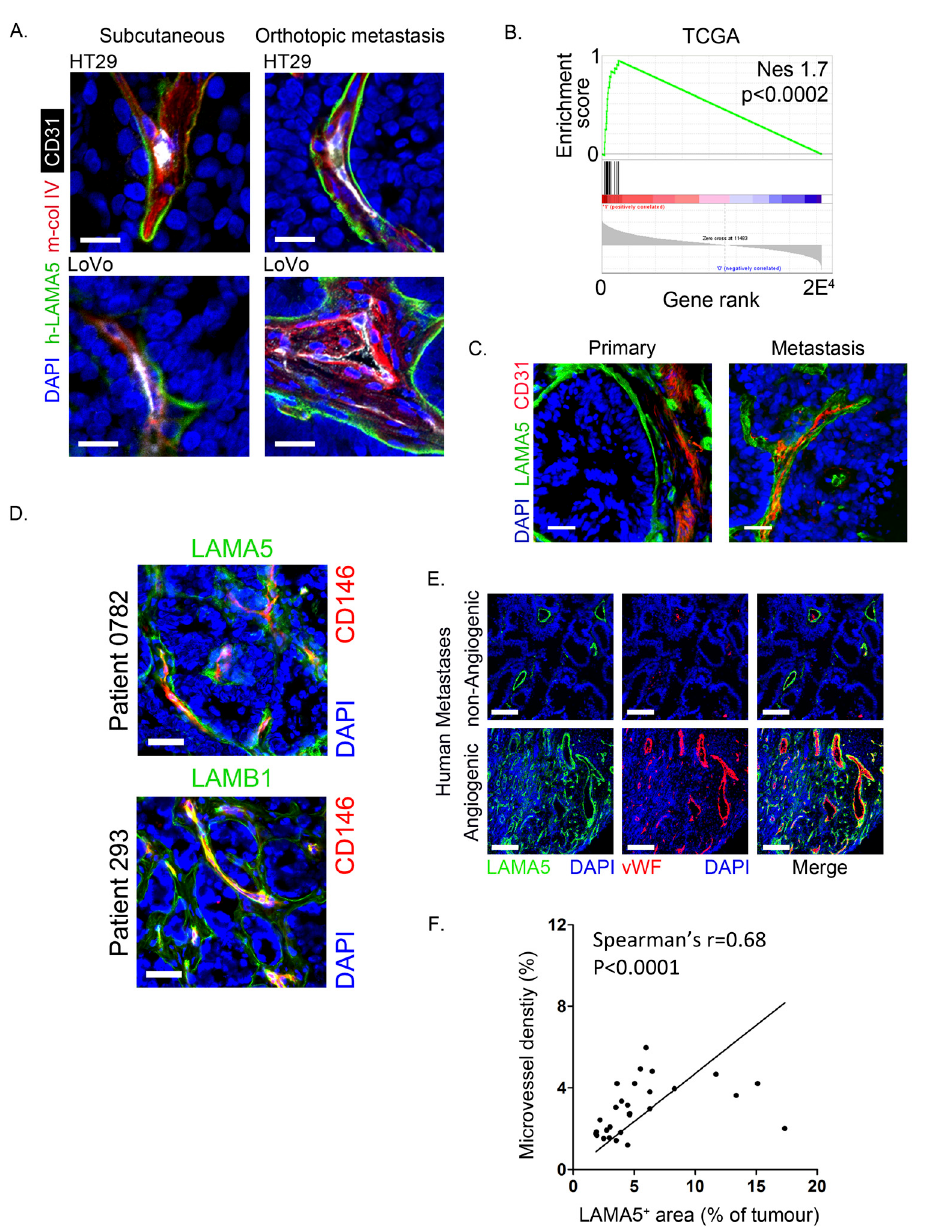
Figure 2. Laminin 511 expression in primary and metastatic colon cancers is associated with angiogenesis. ( A ) Immunofluorescence staining of HT29 (top) and LoVo (bottom) orthotopic liver metastases and subcutaneous tumours stained for LAMA5 (human-specific antibody, h-LAMA5, green), collagen type IV (red) and CD31 (white). Scale bars represent 20 μ m. ( B ) Gene Set Enrichment Analysis (GSEA) for enrichment of a 20-gene signature regulating angiogenesis in TCGA colon cancers over-expressing laminin LAMA5, LAMB1 and LAMC. ( C ) Immunofluorescence staining of archival human primary colon cancer and liver metastasis resection specimens stained for LAMA5 (green) and CD31 (red). Scale bars represent 40 μ m . ( D ) Immunofluorescence staining of archival liver metastasis resection specimens stained for LAMA5 and LAMB1 (both green) and CD31 (red). Scale bars represent 40 μ m . ( E ) Immunofluorescence staining of human liver metastases from a patient with low microvessel density (top row) and one with high microvessel density (lower row) stained for LAMA5 (green) and von Willebrand factor (red). Scale bars represent 100 μ m . ( F ) Scatter plot of the percentage of liver metastasis area staining positive for LAMA5 (x) vs microvessel density (y) determined by measuring the percentage area of the tumour staining positive for von Willebrand factor. Data shown for liver metastases from 30 patients with at least five tumour areas quantified per patient (Spearman’s rank correlation).